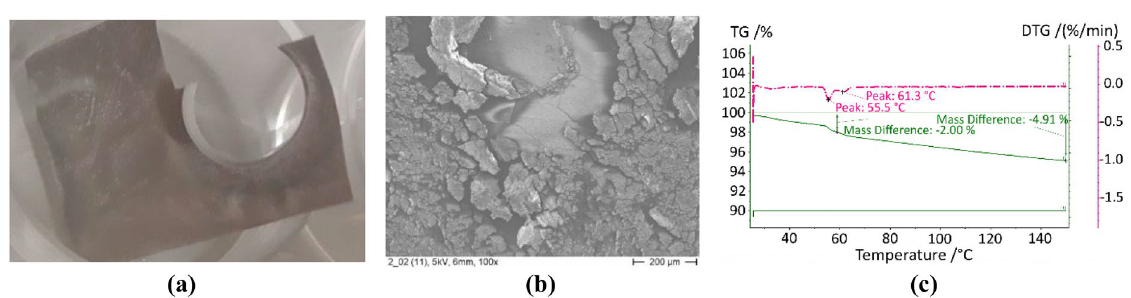
Figure 6. Eloxal with SrCl 2 : real view ( a ), SEM ( b ), and TGA ( c ).